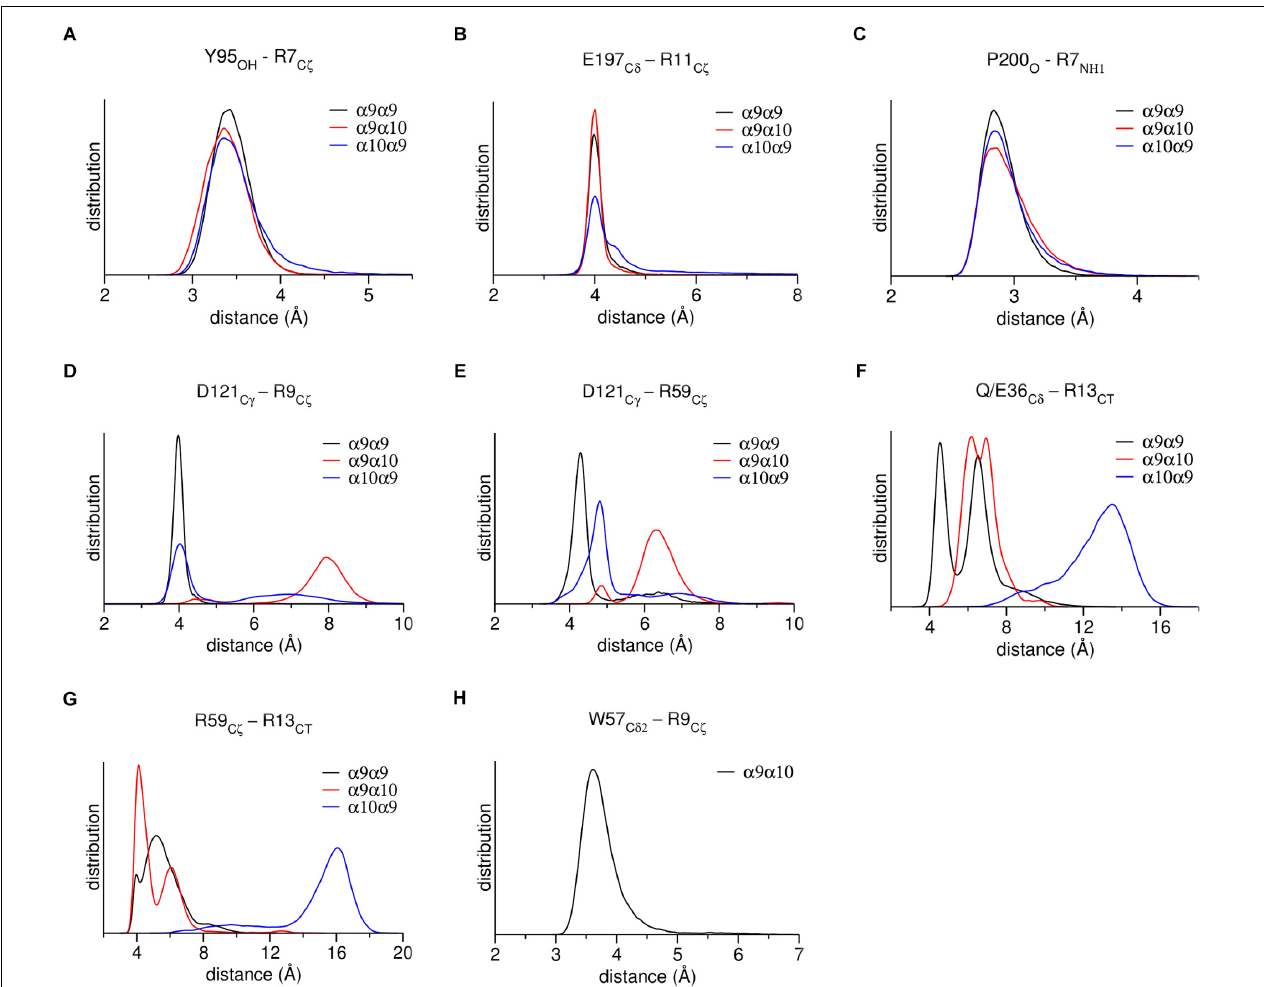
FIGURE 5 | Distribution of distances between characteristic residues, throughout MD simulations. (A) α 9 or α 10 loop-A Tyr95 with RgIA-Arg9. (B) α 9 or α 10 loop-C Glu197 with RgIA-Arg11. (C) α 9 or α 10 loop-C Pro200 with RgIA-Arg7. (D) α 9 or α 10 loop-E Asp121 with RgIA-Arg9. (E) Loop-E Asp121 with loop-D Arg59 in α 9 or α 10 subunits. (F) α 9-Gln36 or α 10-Glu36 with RgIA-Arg13. (G) α 9 loop-D Arg59 with RgIA-Arg13. (H) α 10 loop-D Trp57 with RgIA-Arg9.